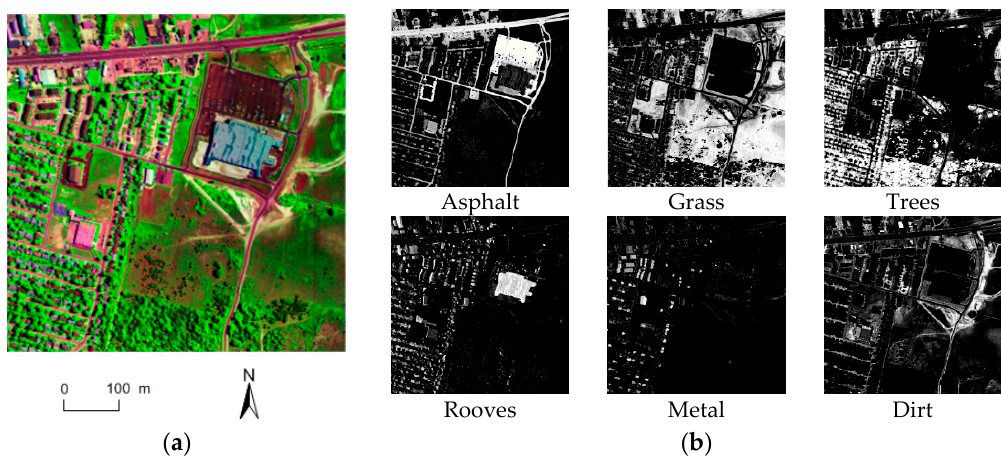
Figure 7. ( a ) False-color image of the Hyperspectral Digital Imagery Collection Experiment (HYDICE) urban data and ( b ) reference abundance maps of the urban data. Table 2. SAD values and their standard deviations (10 − 2 ) for different methods with the urban data. The best result in each row is shown in bold.